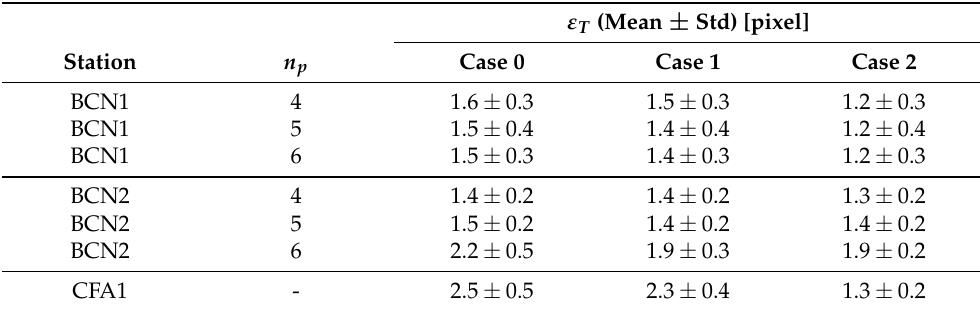
Table 3. The mean and standard deviation of the manual calibration errors, ε T , for cases 0, 1 and 2 and for the different stations and basis.